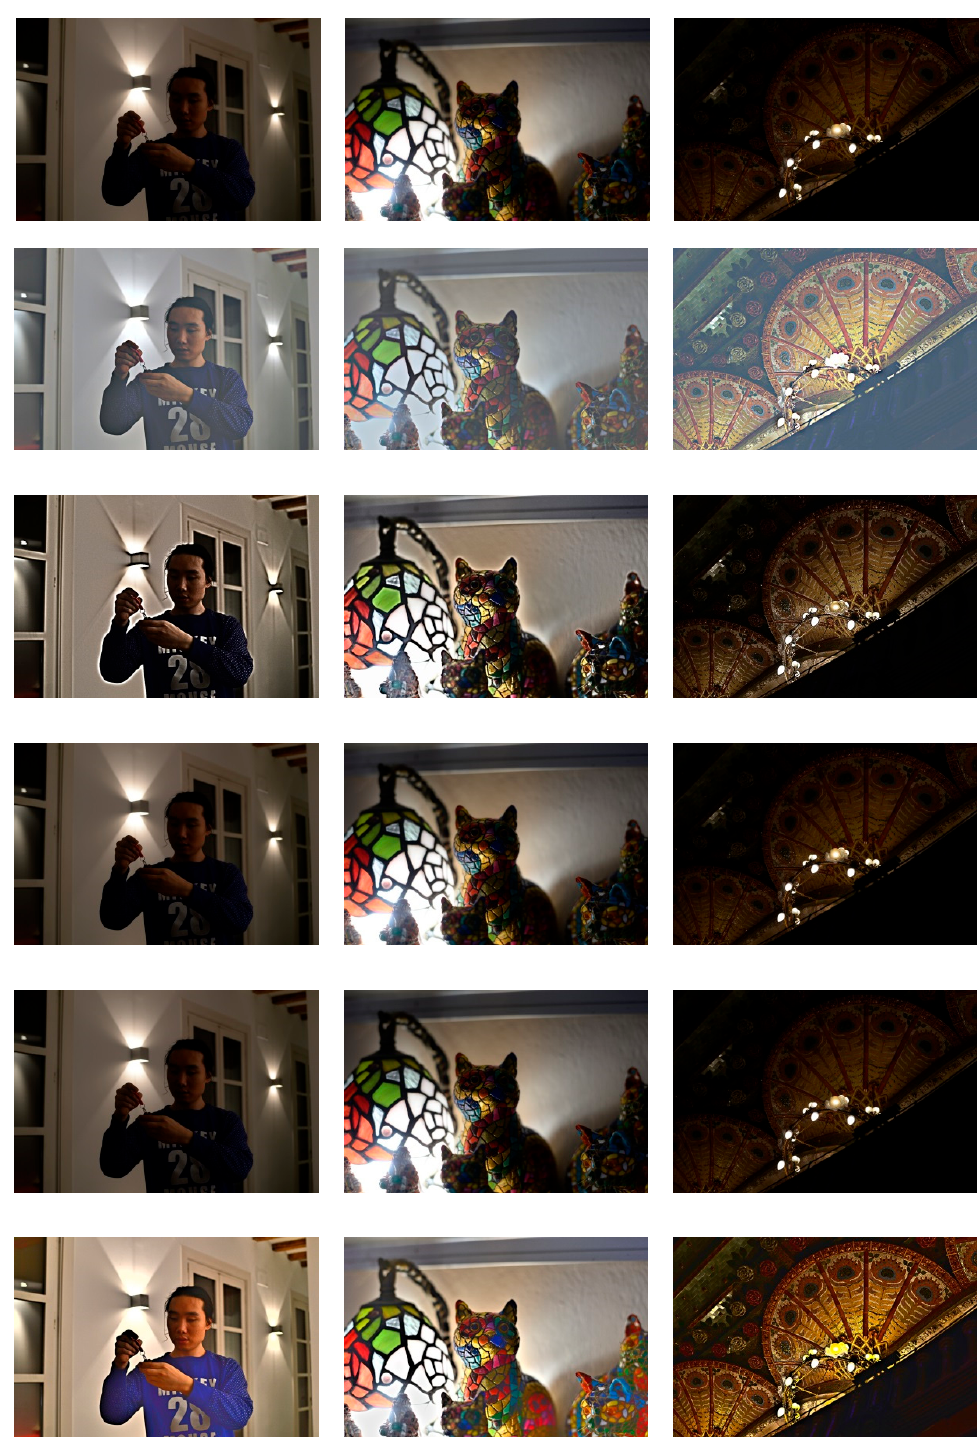
Figure 5. Visual comparisons with B1, B8, and B20 test images: (from top to bottom) low-light image, MSR, AMSR, RSR, LRSR, and proposed method.